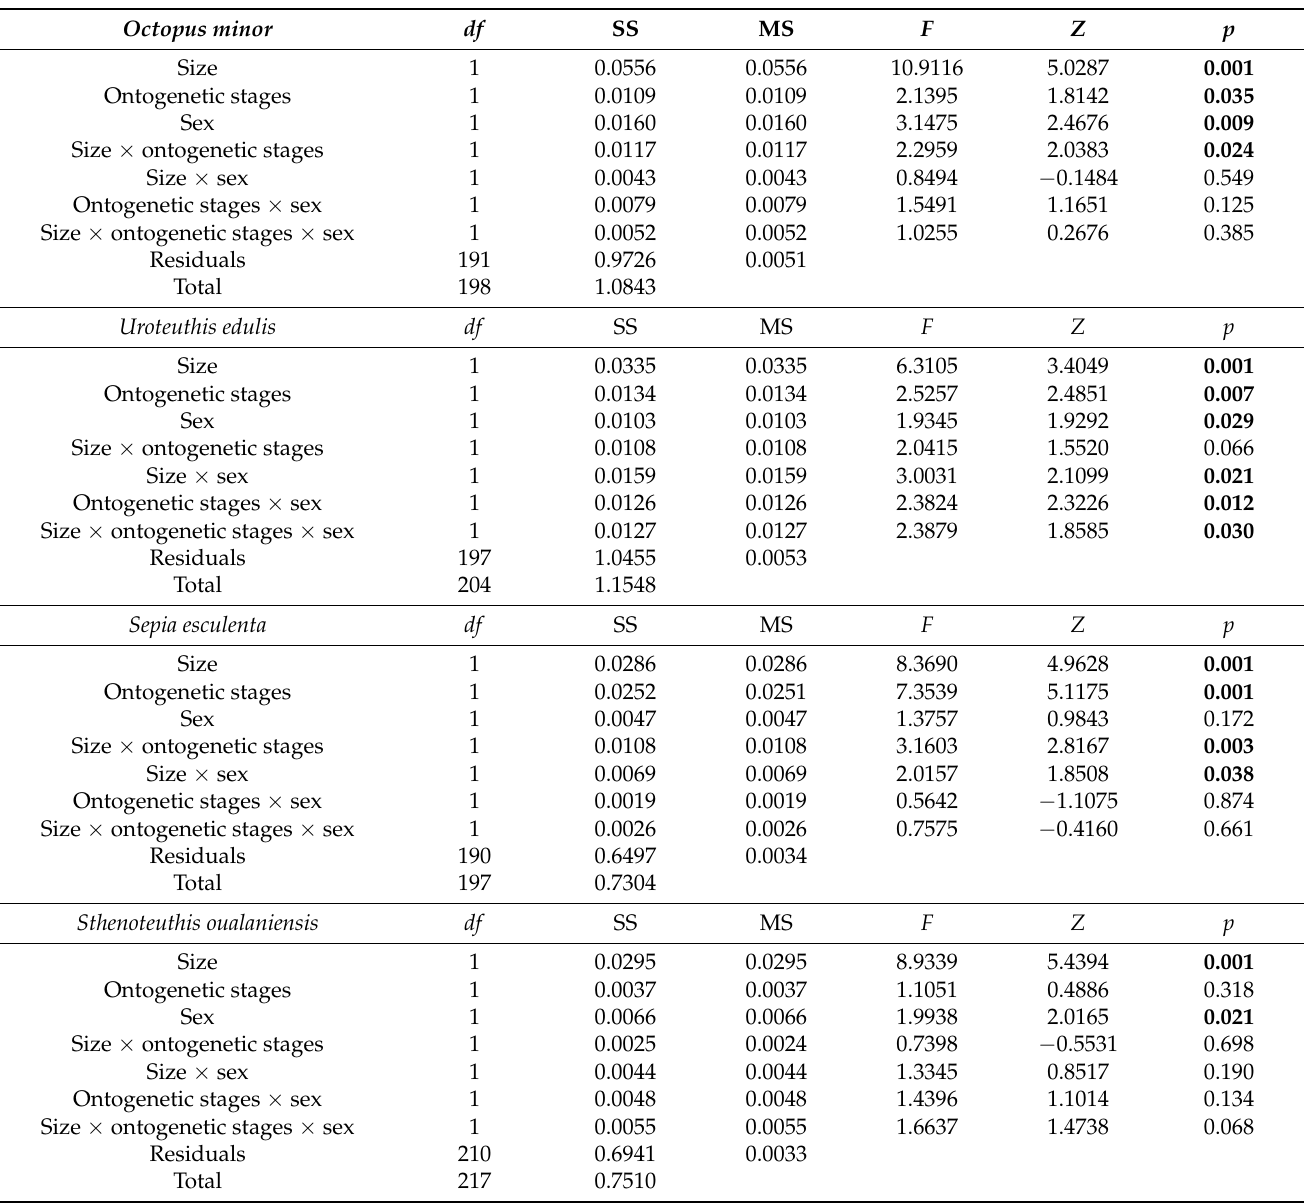
Table 2. Procrustes ANOVA of the shapes of upper beaks of the four cephalopods considered in different ontogenetic